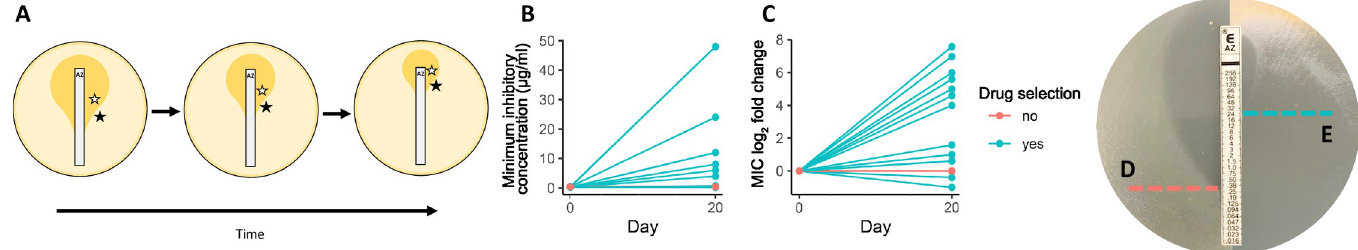
Fig 1. In vitro evolution under azithromycin selection produces high-level resistance in multiple replicate lineages of the Neisseria commensal, N . elongata . (A) Parallel cultures of N . elongata AR Bank #0945 were passaged across an Etest-generated concentration gradient of azithromycin, selecting any cell growth in the zones of inhibition (white stars) and a 1 cm band at the edge of the bacterial lawn (black stars) for 20 days (n = 16 replicates). (B,C) In 7 of the 16 lineages, reduced susceptibility as defined by the CLSI cutoff of � 2 μ g/mL emerged. In all cases, MICs for evolved lineages increased from the ancestral N . elongata AR Bank #0945 strain value of 0.38 μ g/ mL (D), with strain LT1 displayed